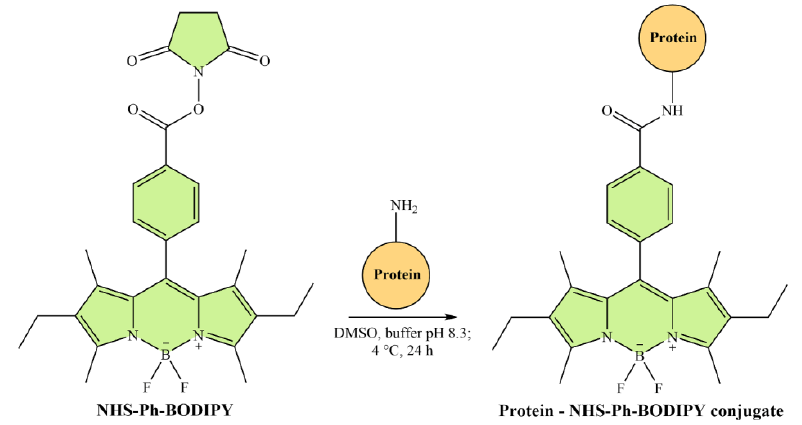
Scheme 2. Scheme of fluorescent labeling of proteins.